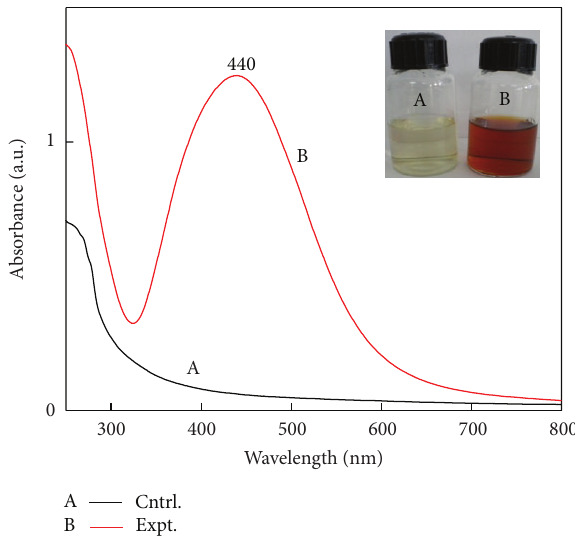
Figure 1: UV-Visible extinction spectra of mycosynthesized spher- ical SNPs colloid. Inset figure: colour change of filtrate from pale yellow (control) (A) to brown (treated) after synthesis of SNPs